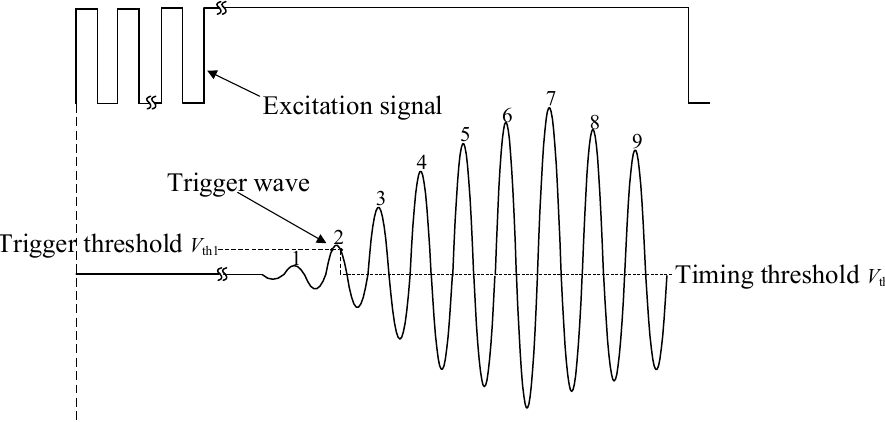
Figure 3. The timing principle of the threshold comparison method (rising edge trigger).